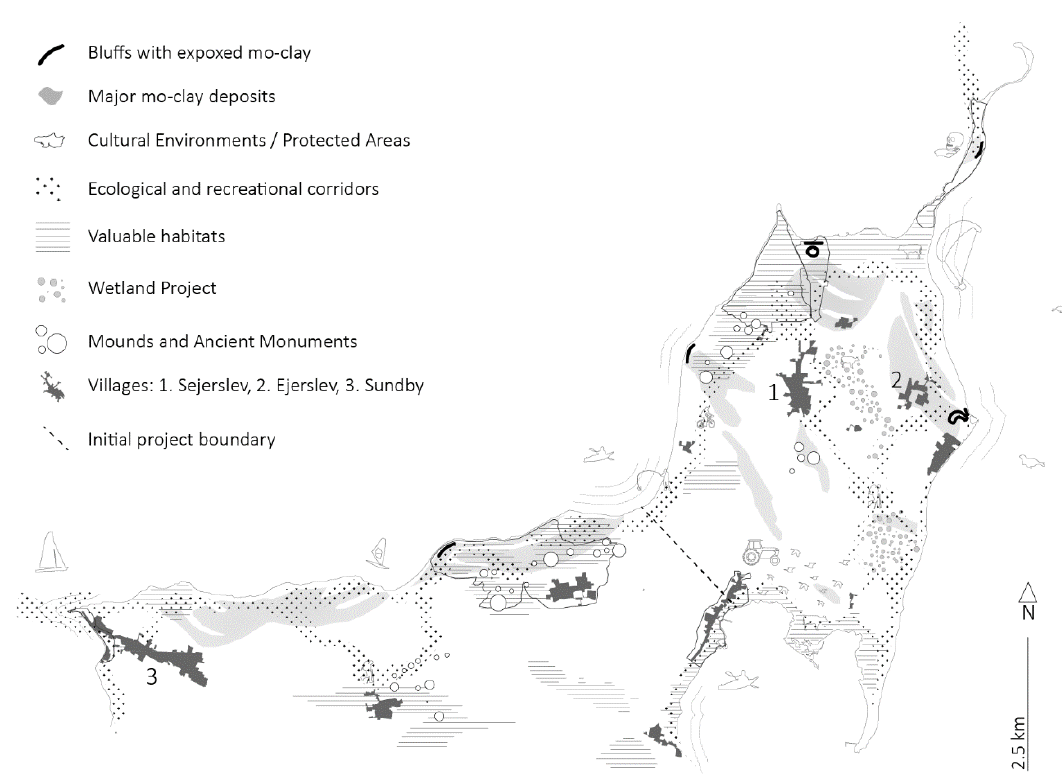
Figure 2. The spatial plan component of the landscape strategy for the hills of Northern Mors.